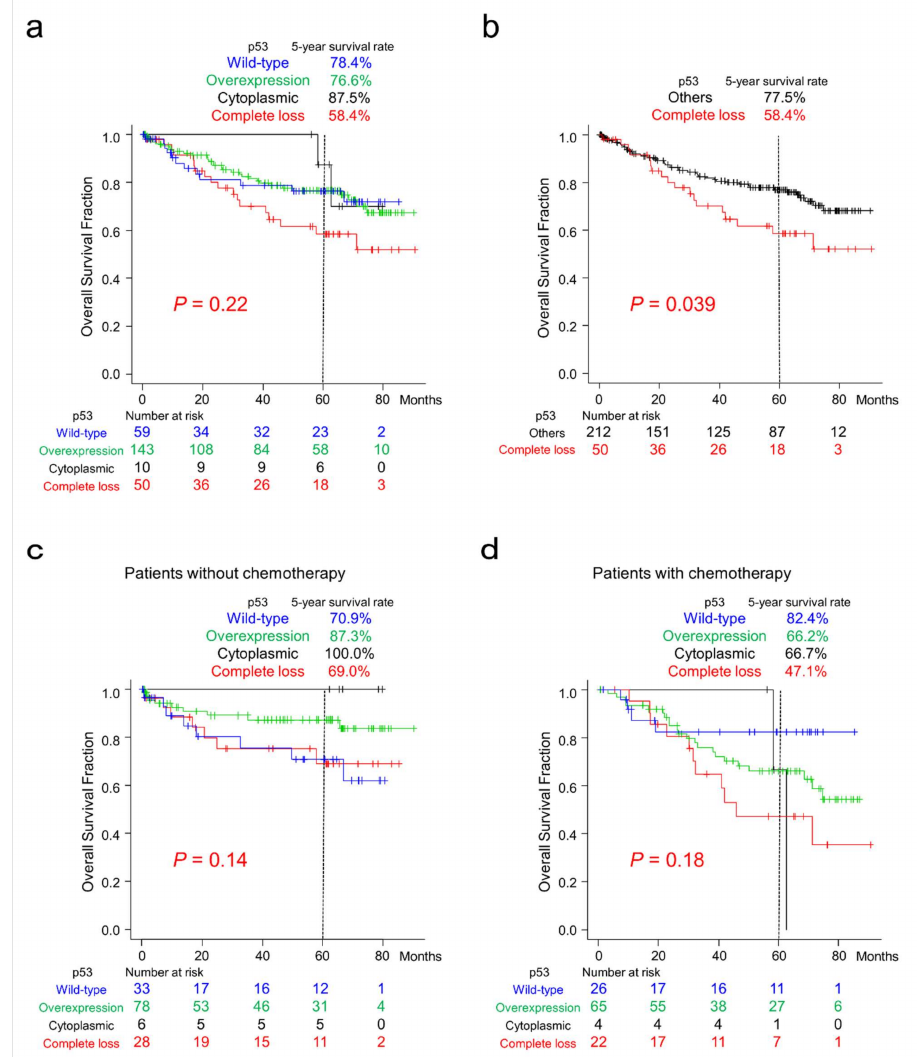
Figure 4. Overall survival of patients with CRC classified according to p53 immunoreactivity. ( a ) Kaplan–Meier curves for patients classified according to the four p53 expression patterns. CRC patients with complete loss of p53 tended to show worse survival. ( b ) Kaplan–Meier curves for patients classified into two groups according to p53 immunoreactivity. Note that CRC patients with complete loss of p53 showed significantly worse survival than the group with the other three expression patterns. ( c ) Kaplan–Meier curves for patients without chemotherapy classified according to four different p53 expression patterns. CRC patients with wild-type p53 expression tended to show worse survival than the others. ( d ) Kaplan–Meier curves for patients with post-surgery chemotherapy classified according to p53 immunoreactivity. CRC patients with wild-type p53 expression tended to show more favorable survival than the group with p53 overexpression or complete